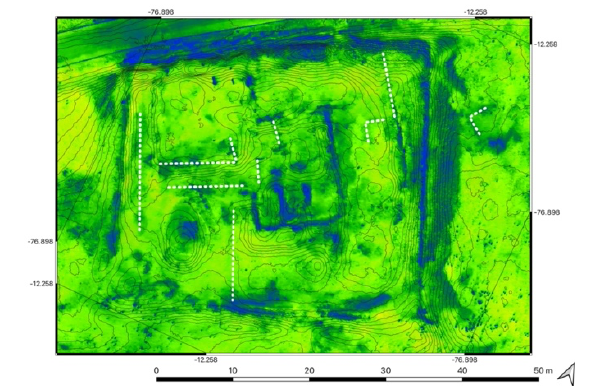
Figure 17 . Crossed results of the various surveys of zone B15 with visualization of some first potential buried structures (white tilled lines)